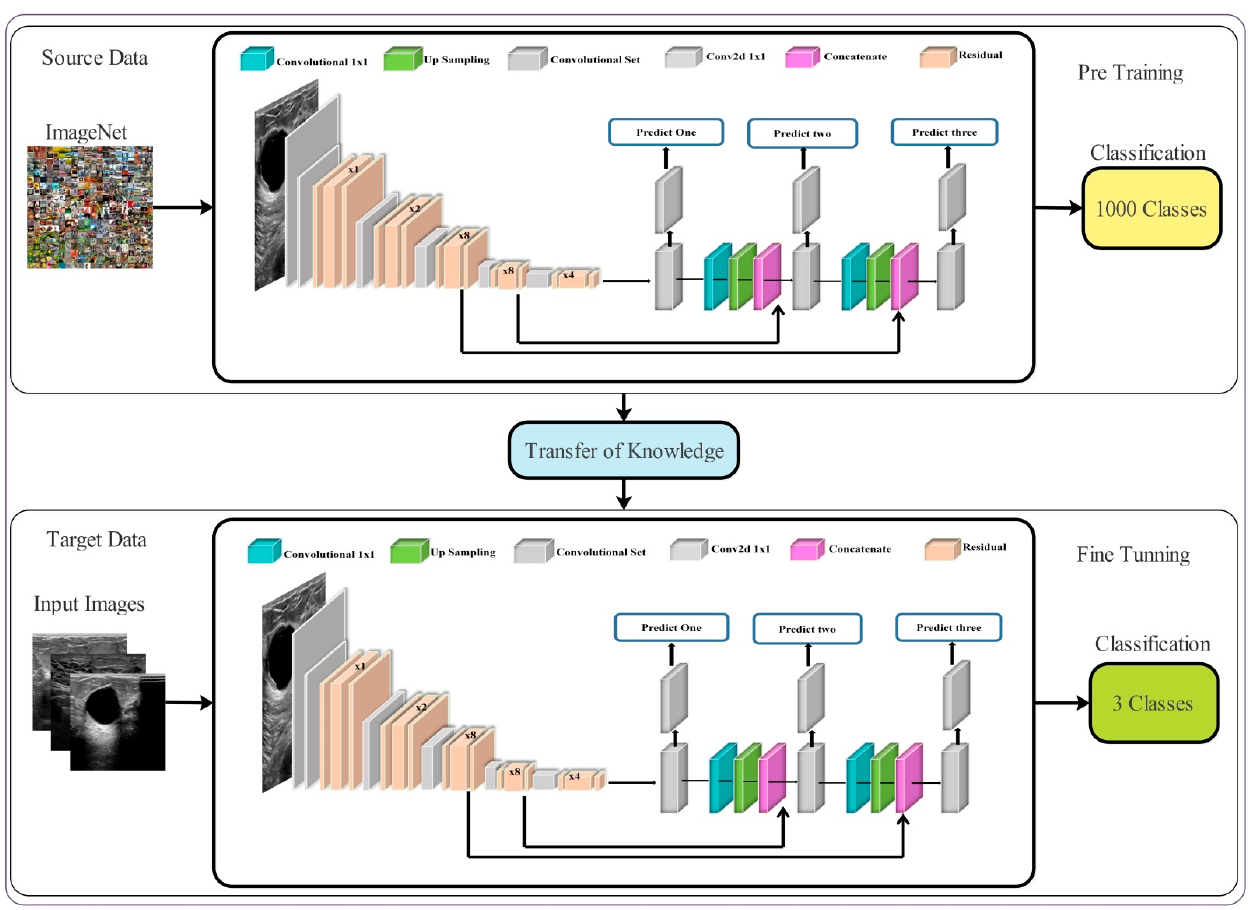
Figure 5. Transfer learning-based training of modified model and extract features.